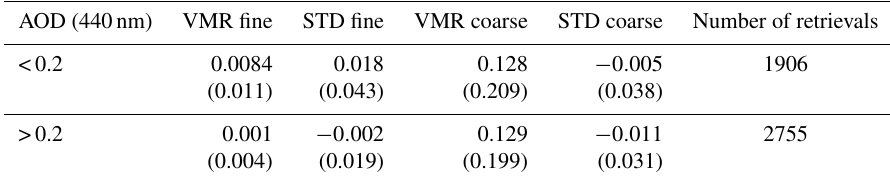
Figure 12. Hybrid scan geometry depicted for four values of SZA. See explanations in text. Table 9. Statistics, average values and standard deviations (in parentheses) of the difference in volume median radius (VMR) and width of particle size distribution (STD) retrievals of V2 and V3 for the Mongu site. The difference is defined as V3 −